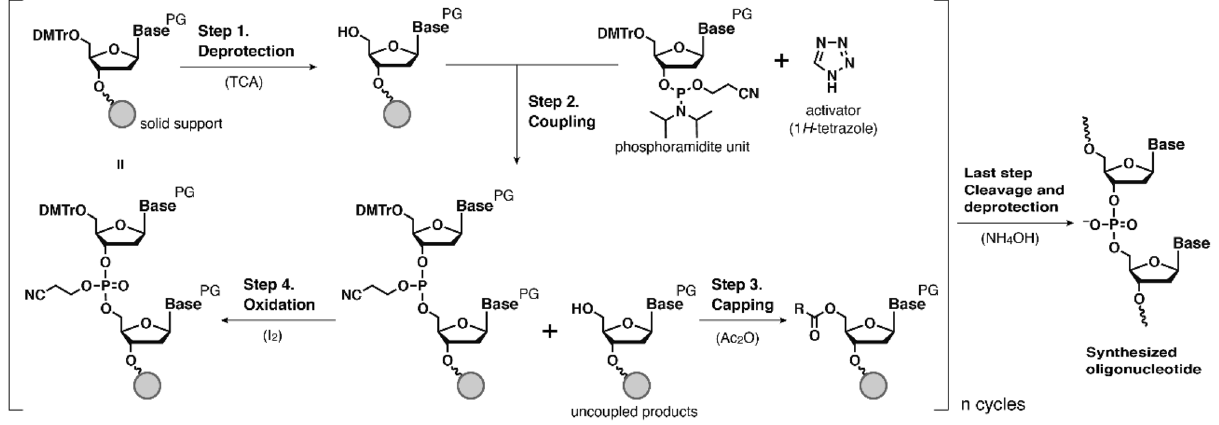
Figure 1. Phosphoramidite chemistry for DNA